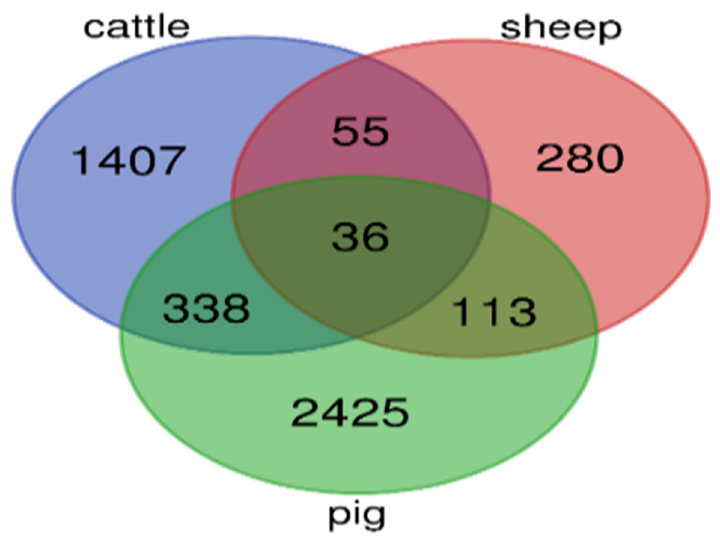
Figure 1. Number of common genes identified between three species using Venn diagram. Table 2. Common genes among Bos taurus, Ovis aries , and Sus scrofa .